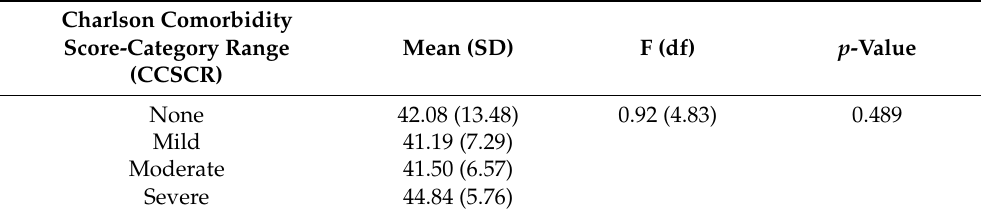
Table 8. Independent t -test to determine the association between tumour stage and medical comor- bidity status among patients with colorectal